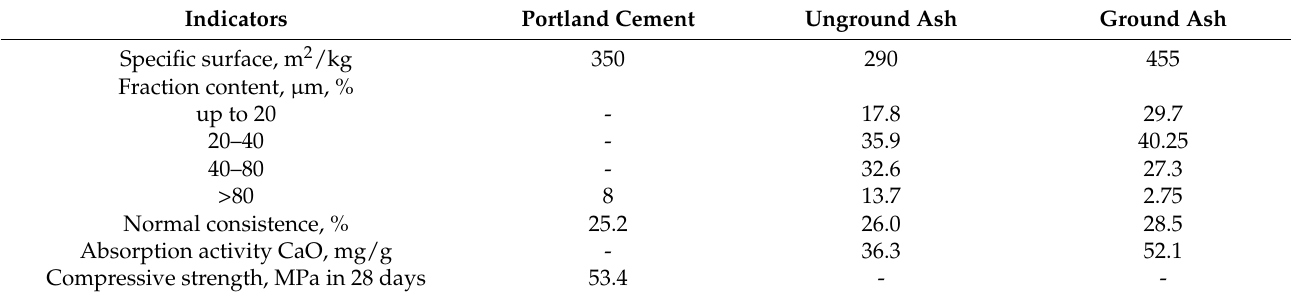
Table 3. Physical properties of fly ash and Portland